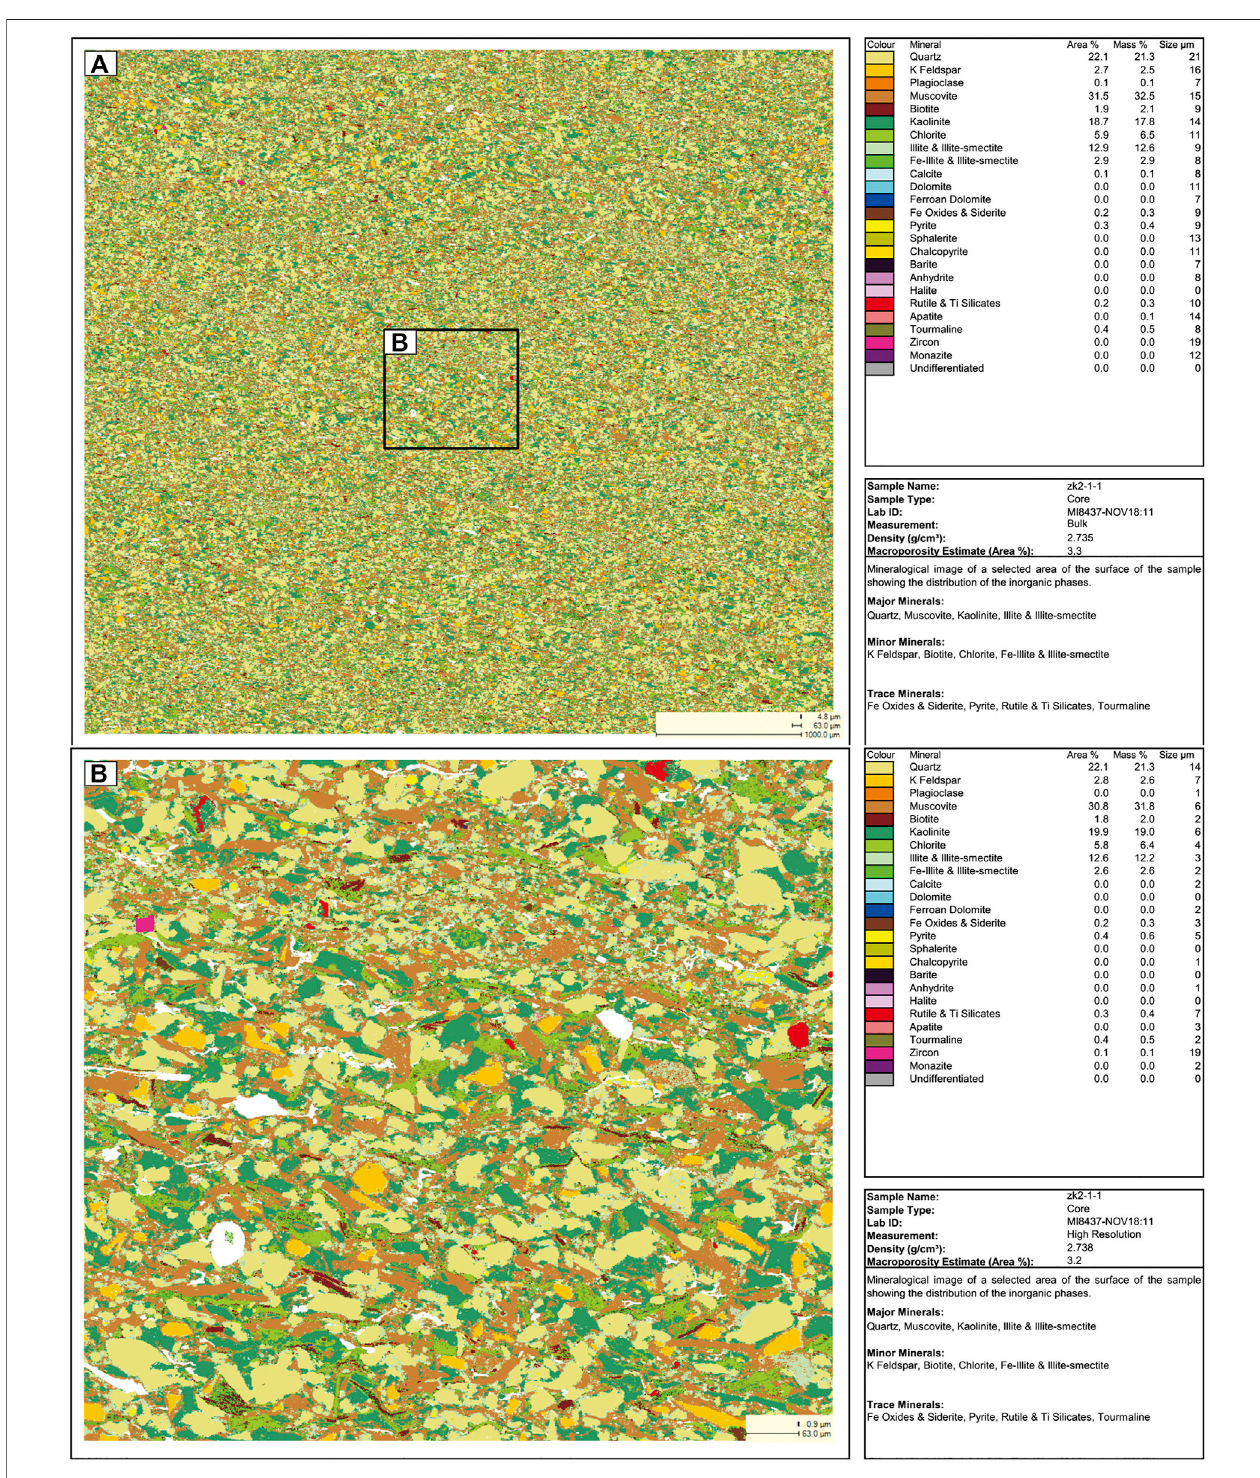
FIGURE 5 | QEMSCAN image of sample ZK2-1-1. (A) Bulk measurements and (B) high-resolution measurements.